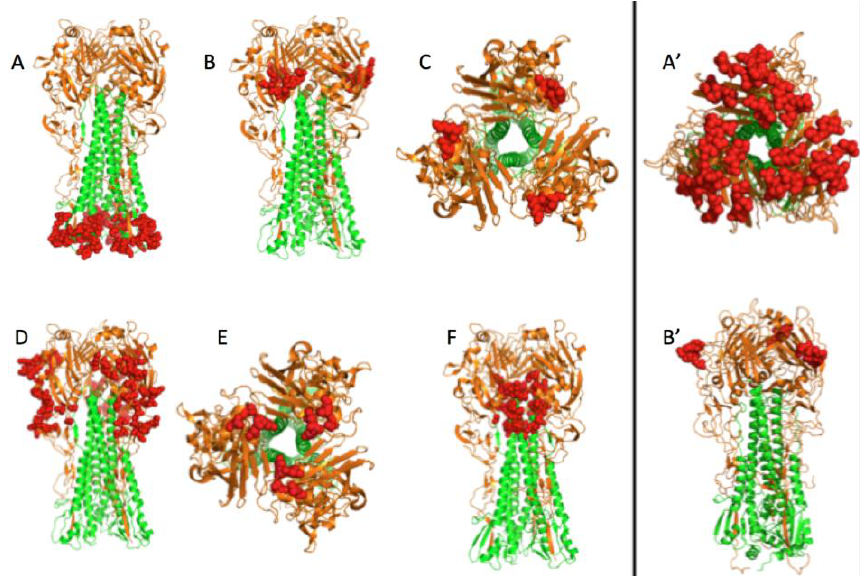
Figure 4. 3D view of the six potential therapeutic targets on H1N1 and two on H3N2. Red spheres are the targets. HA1 subunits mainly forming the globular head of HA are in orange. HA2 subunits that mainly form the stem of HA are in green. Lists of positions of these six targets are described in Figure 3. Target A is localized at the bottom of the stem on HA2. Targets B, C, D, and E are localized on HA1. Target F is at the junction between HA1 and HA2. Target A’ and B’ are on H3N2 HA1.